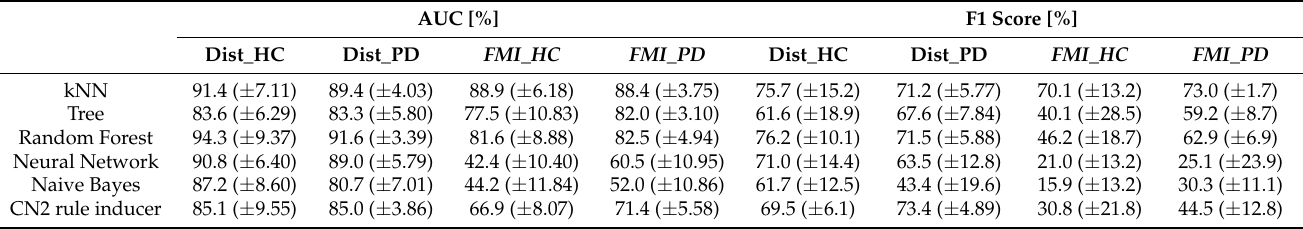
Table 4. Results of supervised classification. AUC and F1 values are reported for the different classification methods. Dist_HC and Dist_PD refer to the dataset of normalized distances with the preprocessing step of PCA, whereas FMI_HC and FMI_PD refer to the FMI dataset. AUC